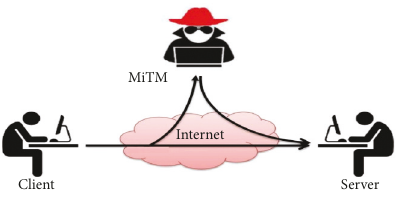
Figure 2: Example of MiTM